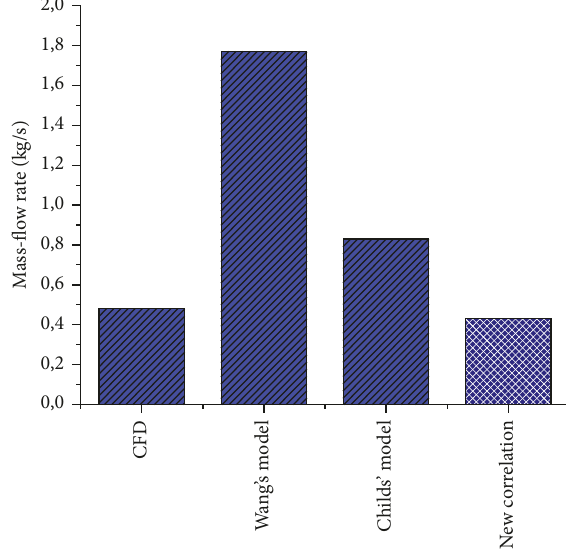
Figure 21: Mass-flow rate